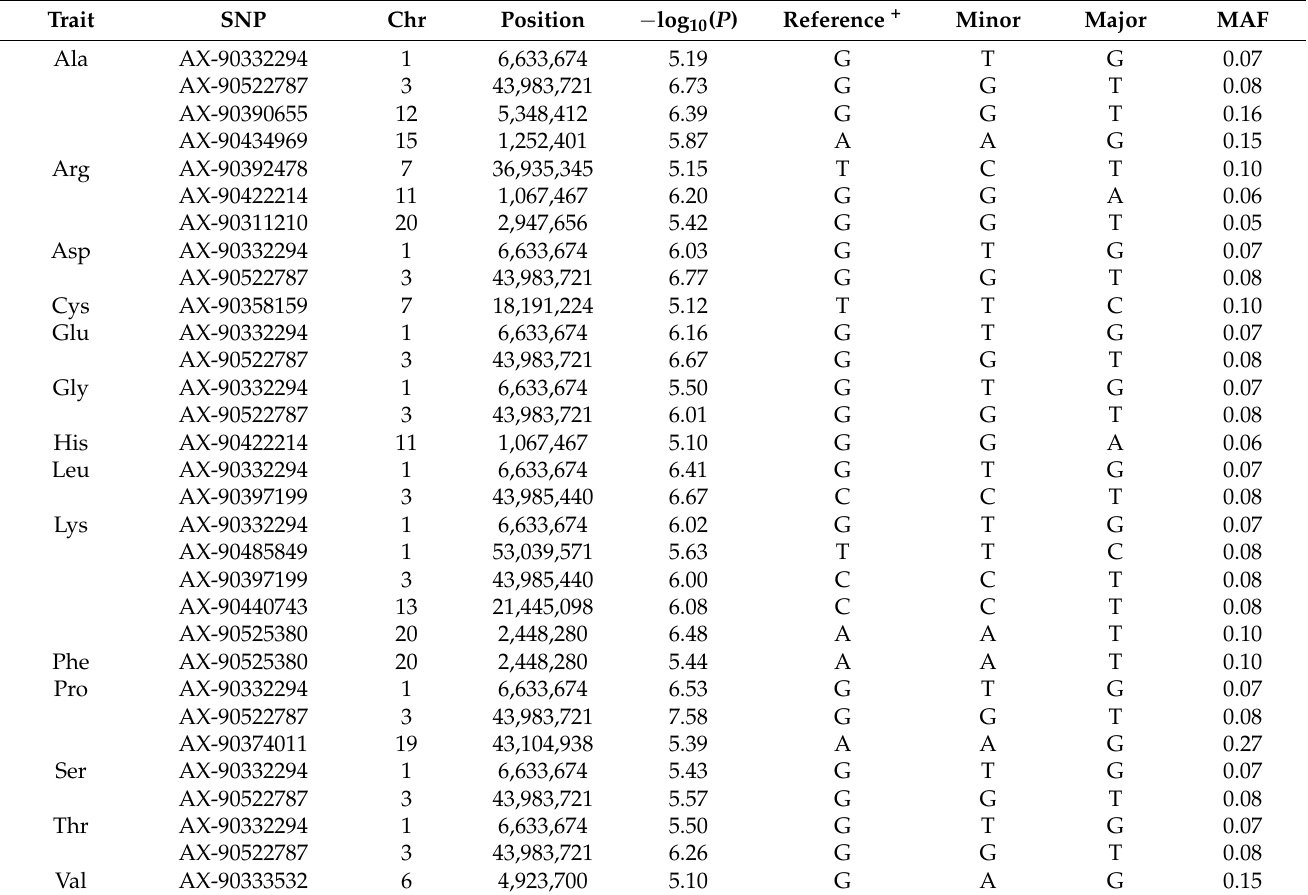
Table 4. Signi fi cant SNP markers related to amino acid contents in the merged phenotype.